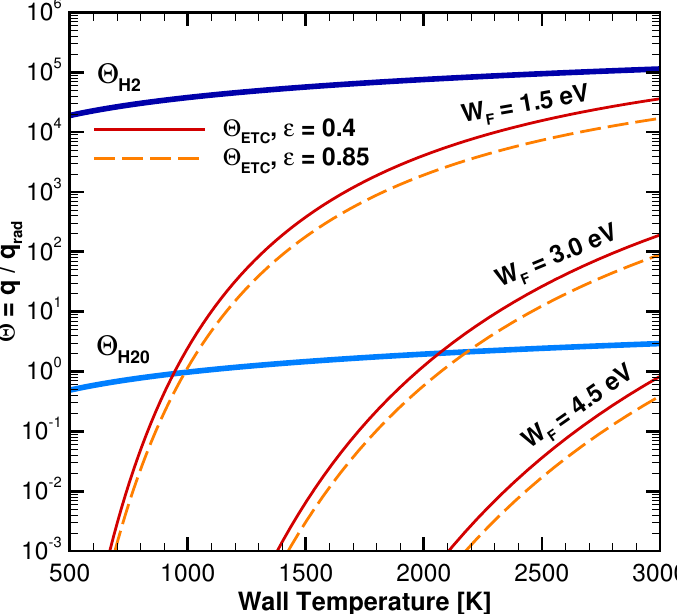
Figure 1. Maximum cooling rates from evaporative and thermionic materials relative to the equiva- lent level of radiative